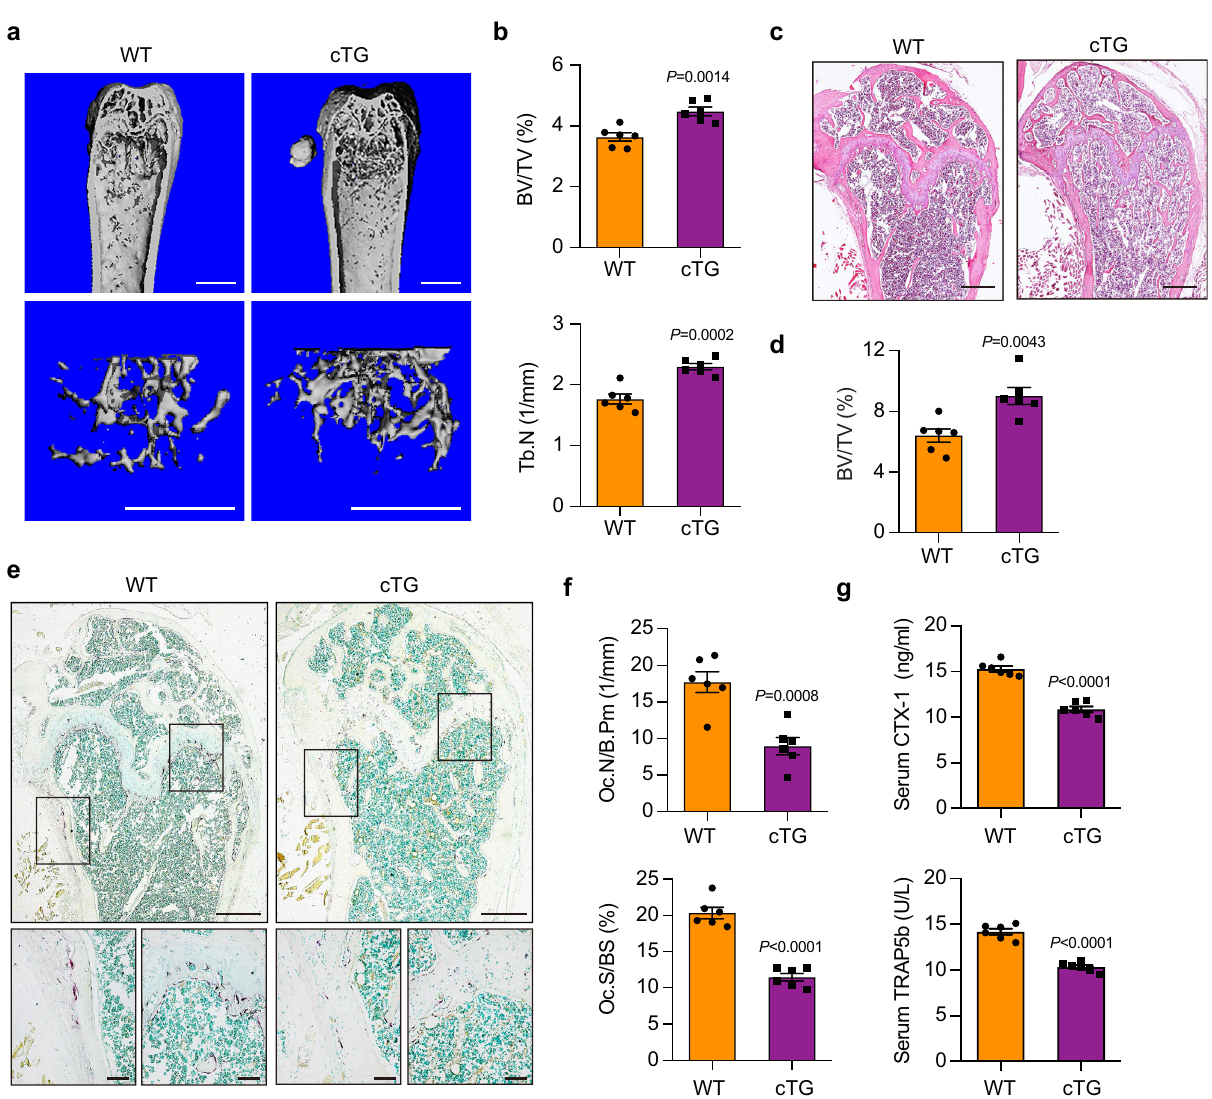
Fig. 3 Increased bone mass in Nron cTG mice due to suppressed bone resorption. a Representative μ CT images showing the 3D bone structures of femurs from 6-month-old female WT littermates and Nron cTG mice, (similar results were obtained in all mice, n = 6/group). Scale bar: 1 mm (all panels). b μ CT measurements of BV/TV and Tb.N in femurs from 6-month-old female WT littermates and Nron cTG mice, ( n = 6/group). c Representative H&E staining images of femurs from 6-month-old female WT littermates and Nron cTG mice, (similar results were obtained in all mice, n = 6/group). Scale bar: 500 μ m. d Histological measurements of BV/TV values in c , ( n = 6/group). e Representative TRAP staining images of femurs from 6-month-old female WT littermates and Nron cTG mice, (similar results were obtained in all mice, n = 6/group). Scale bar: 500 μ m (upper panels); 100 μ m (lower panels). f Quanti fi cation of osteoclastic metrics Oc.N/B.Pm and Oc.S/BS in subepiphyseal region of femurs in e , ( n = 6/ group). g Serum CTX-I and TRAP5b levels of 6-month-old female WT littermates and Nron cTG mice analyzed by ELISA, ( n = 6/group). Data